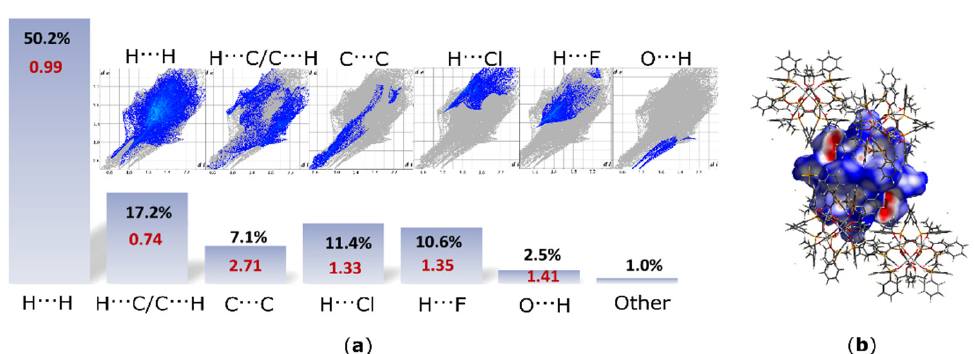
Figure 7. ( a ) 2D fingerprint plots (FPs) for the hexacation of I with the percentage contributions to the Hirshfeld surface (HS) areas for the major intermolecular contacts and their respective enrichment ratio (ER)—in red; d e and d i are the distances to the nearest atom exterior and interior to the surface, respectively; ER values were not computed for the actual contacts’ contribution below 2% and random contacts below 1%, as they are not meaningful. ( b ) Hirshfeld surfaces (HSs) generated for the cation of I ; d norm is visualized with a fi xed color scale from − 0.655 (red), 0.428 (white) to 1.442 (blue).